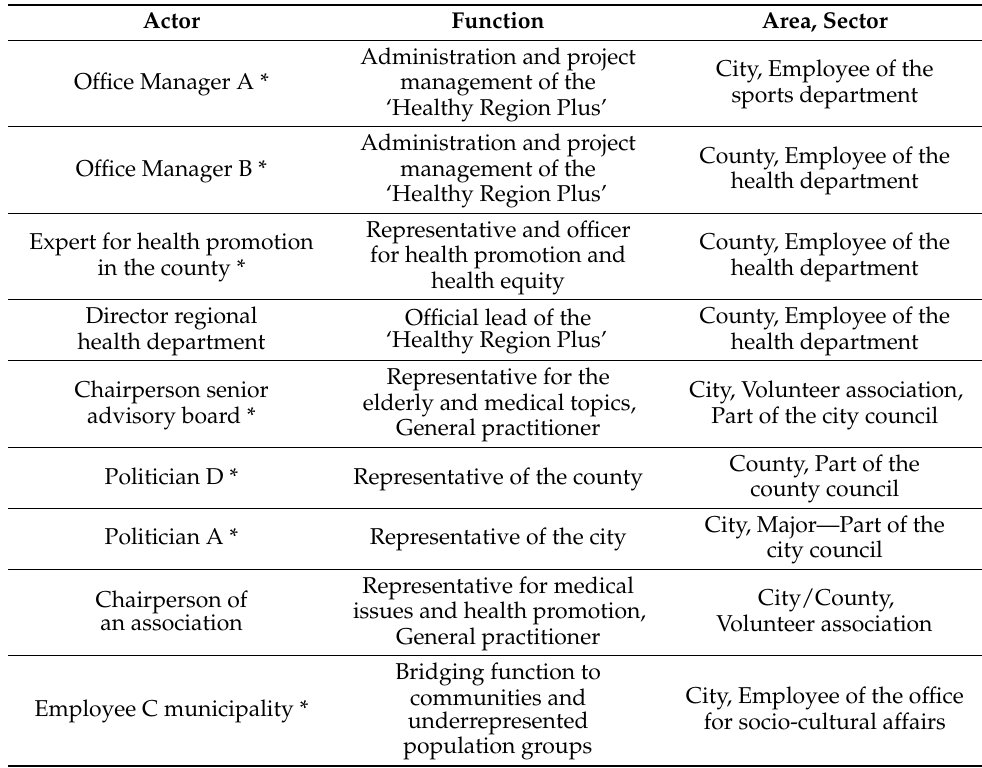
Table 1. Official members of the steering